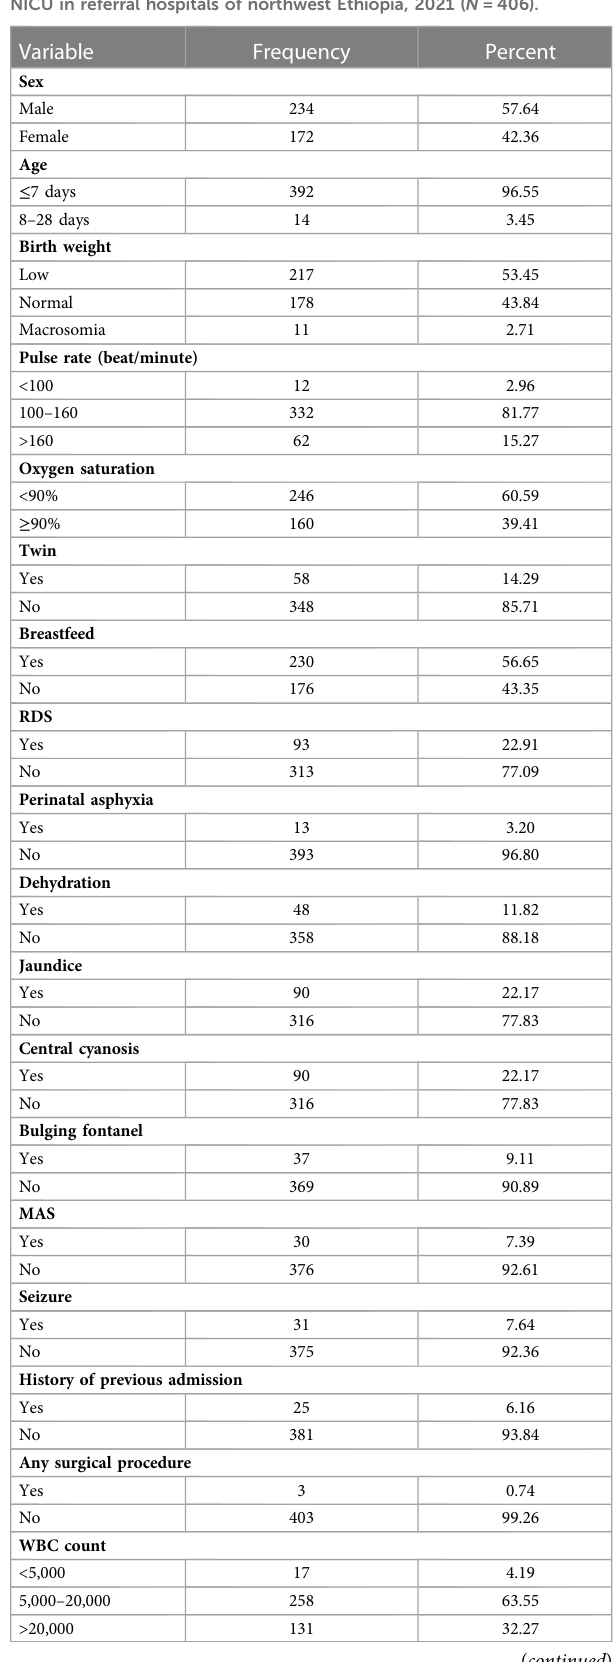
The overall goodness of fi t of the exponential regression model was tested by applying the Cox-Snell residual plots. As shown in Figure 3 , the line associated with the Cox-Snell residual of the exponential Cox regression model was closer to 45° straight lines of the origin which indicate that model is well- fi tted.